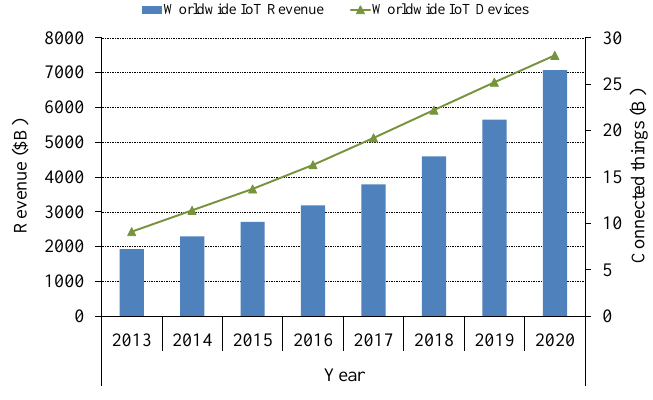
Figure 1. Worldwide IoT connected devices and revenues forecast. Data extracted from [5].